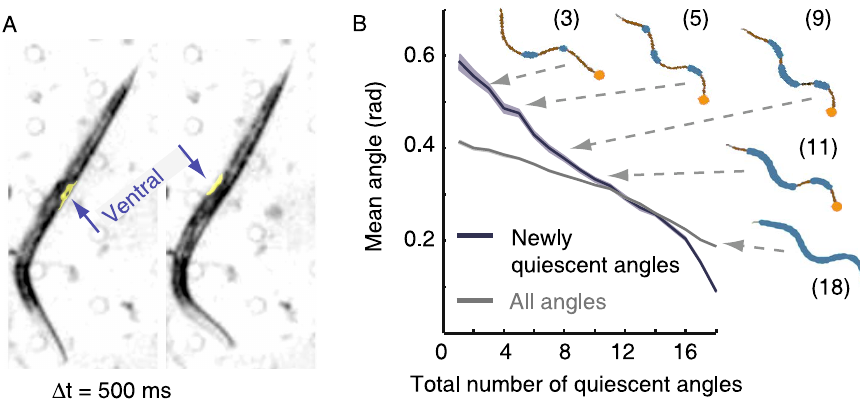
Figure 1. C.elegans enter the quiescent posture with stereotypical dynamics. (A) A hockey-stick-like posture containing a single body bend, commonly observed during lethargus quiescence bouts (see also Fig. 3) before (left) and after (right) a flip. The image on the right was captured 500 ms after the image on the left, by which time the flip had been completed. The arrows point to the ventral side of the animal in each of the two figures. (B) The average angle at positions along the body that were becoming quiescent as the animals were entering bouts of quiescence. Eighteen equidistant positions along the body were individually assayed for quiescence at every time-point during L4leth, and initiations of whole-animal bouts of quiescence were identified. The angles between adjacent segments of the midline at positions that newly became quiescent were compared to the mean of all 18 angles at the same time-point. Animals initially froze high-curvature body-positions and subsequently lower- curvature positions also became quiescent, indicating a stereotypical dynamics of entering a quiescence bout. In addition, five snapshots of midlines are shown, taken from a single event of entering a bout of quiescence. The orange circles depict the head of the animal, the thick blue lines depict the quiescent angles along each midline, the numbers in parenthesis indicate the total number of quiescent angles in each midline, and the arrows point to the corresponding position on the plot. The plot depicts data from N=37 animals, mean 6 s.e.m. Standard errors are illustrated as shadowed areas surrounding the plotted averages. The datasets of newly quiescent angles and all angles were statistically distinct (p , 10 2 12